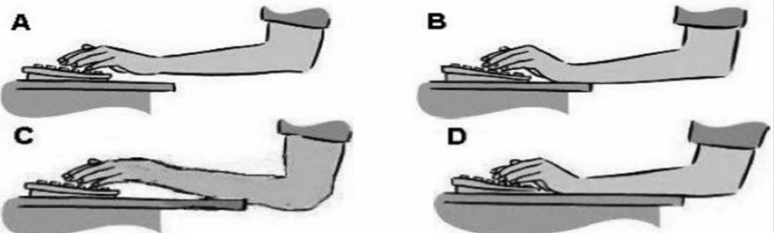
Figure 2. Diagrams selected by participants to describe their wrist and hand positions while typing. ( A ). Wrist and hand floating, ( B ). Keyboard is placed nearer. ( C ). Wrist is extended to reach the keyboard. ( D ). Keyboard is placed further. Reprinted with permission from